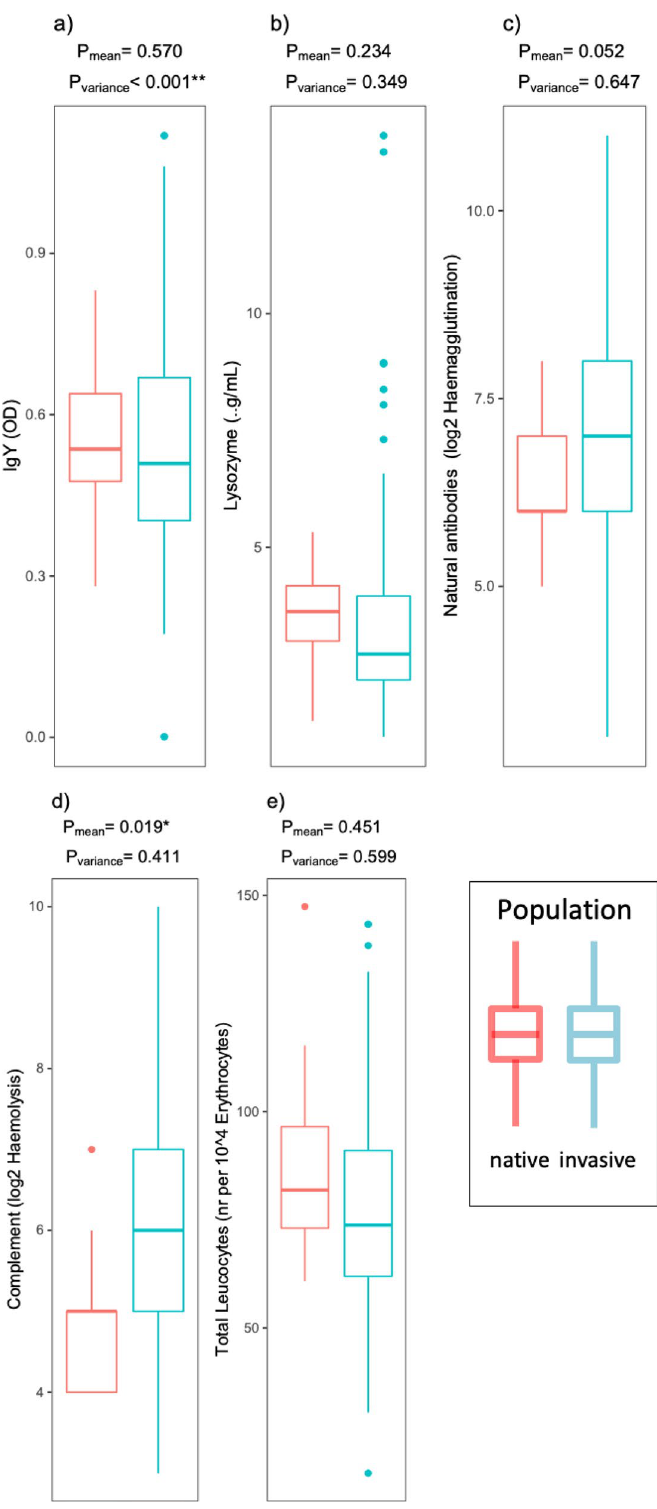
Figure 1. Differences in distributions of low cost ( a – d ) and high cost ( e ) immune measures between native and invasive Egyptian geese are shown; red = native; blue = invasive; P = p -values for the effects of population (native vs. invasive) on the mean (P mean ) and variance (P variance) of the respective immune measure from the GLMMs (see Tables S3, S4). For sample sizes of each immune measure for the two populations see Table